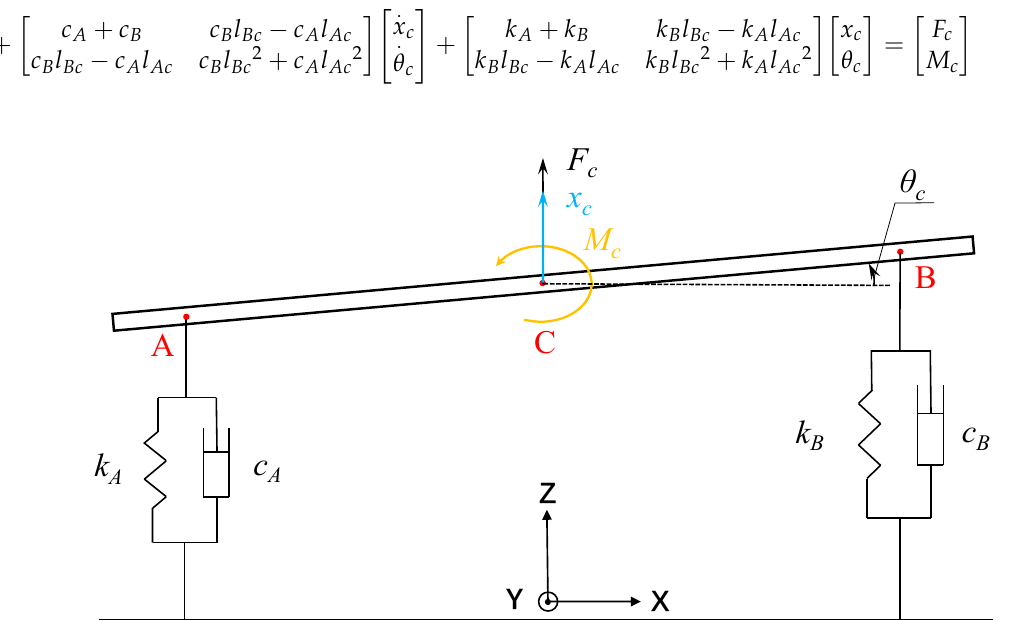
Figure 2. Dynamic model of vertical direction of X -axis slide.